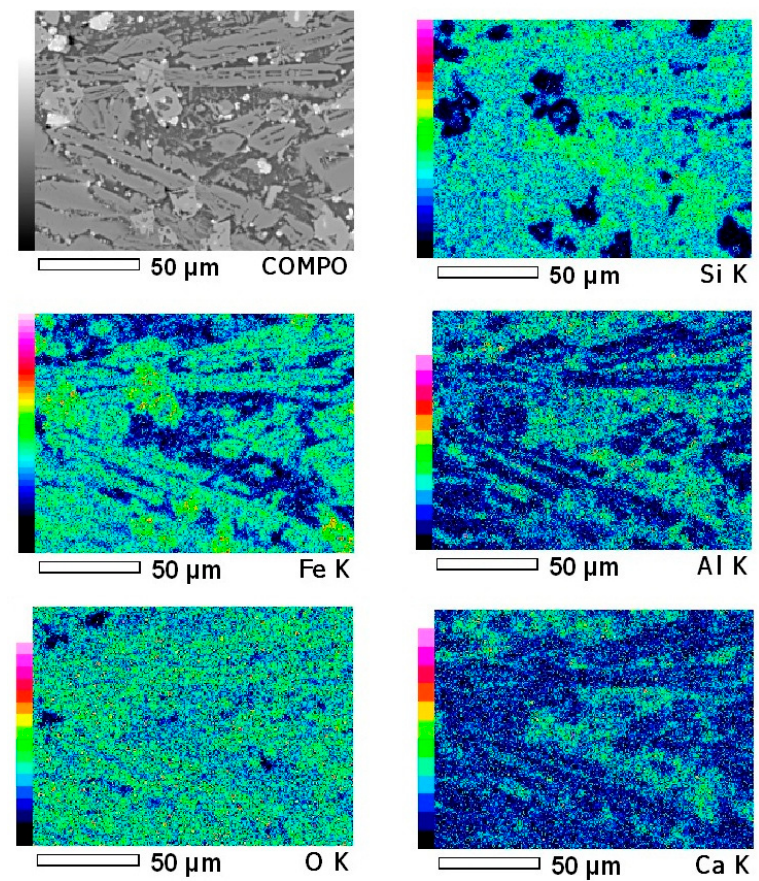
Figure 4. Element mapping of the Si, Fe, Al, Ca in the slag.